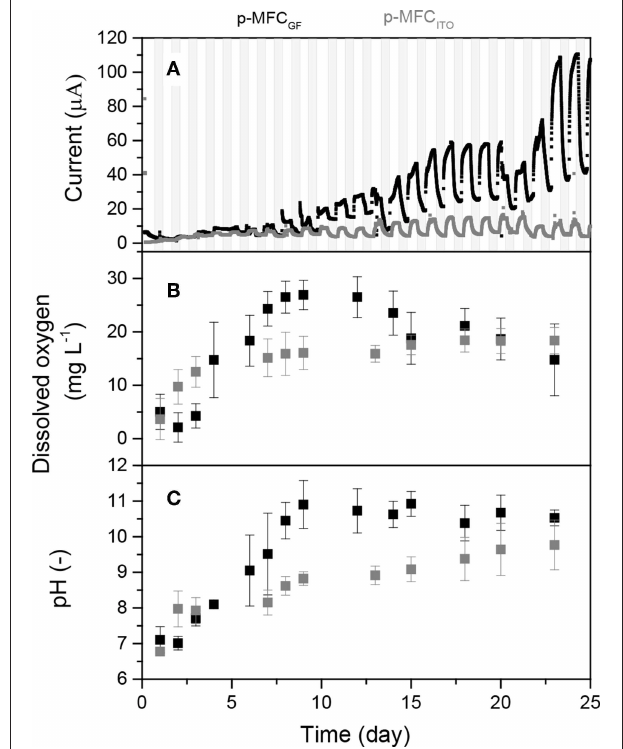
FIGURE 1 | (A) Output current over time generated by the p-MFCs during the first 25 days of operation (start-up period). Data is the average of six replicates. Shadowed areas indicate the operation during the dark cycle. Figure S5 shows data with error bars and data normalized by projected surface area. (B) Dissolved oxygen in the catholyte during the start-up period. (C) pH and conductivity evolution of the catholytes during start-up. In all the graphs, data related to p-MFC ITO are reported in gray and data related to p-MFC GF are in